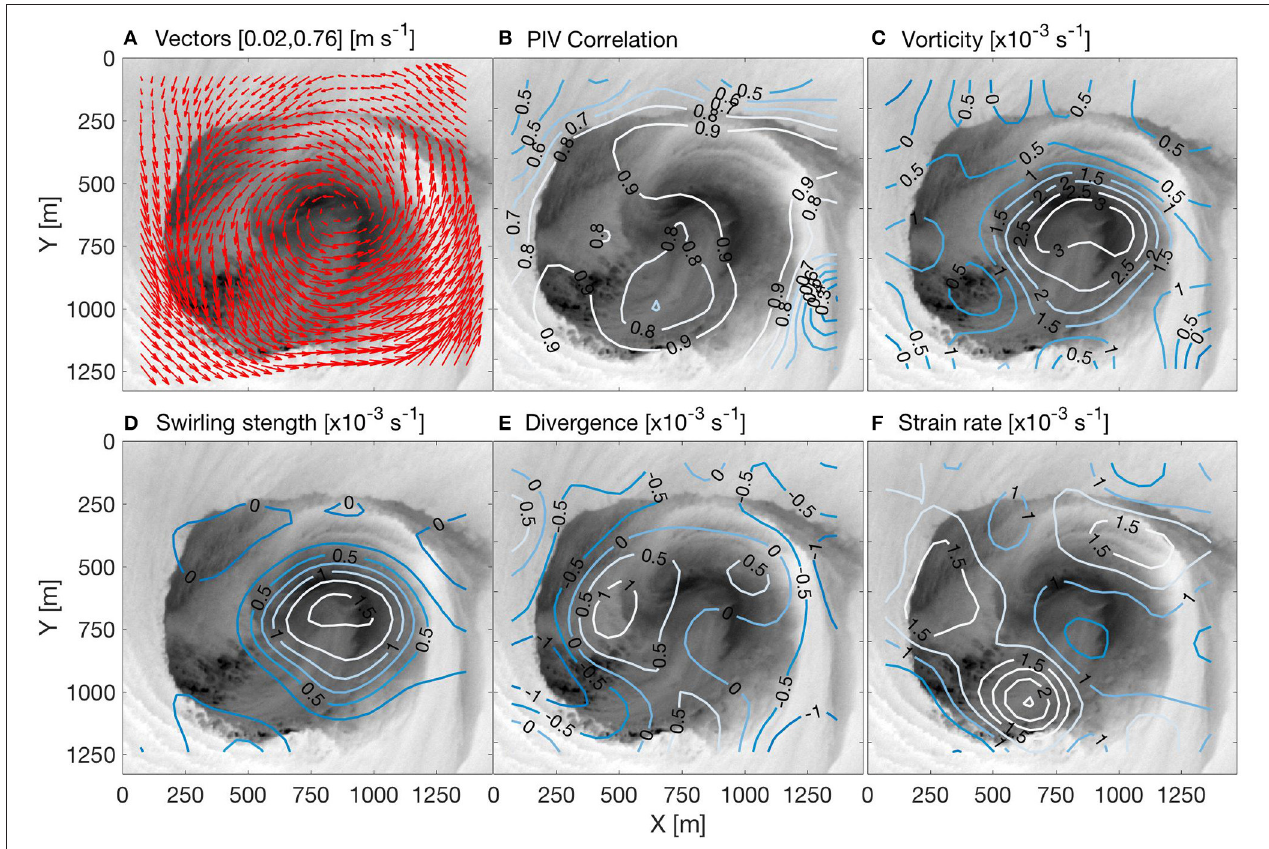
FIGURE 4 | Velocity and kinematic properties derived from infrared data from 2057 UTC. (A) Vector field; (B) Cross-correlation peak; (C) Vorticity; (D) Swirling strength; (E) Divergence; (F) Strain